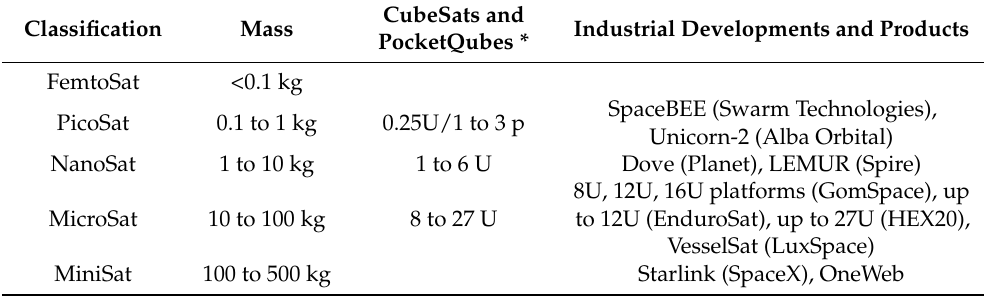
Table 2. Classification of small satellites